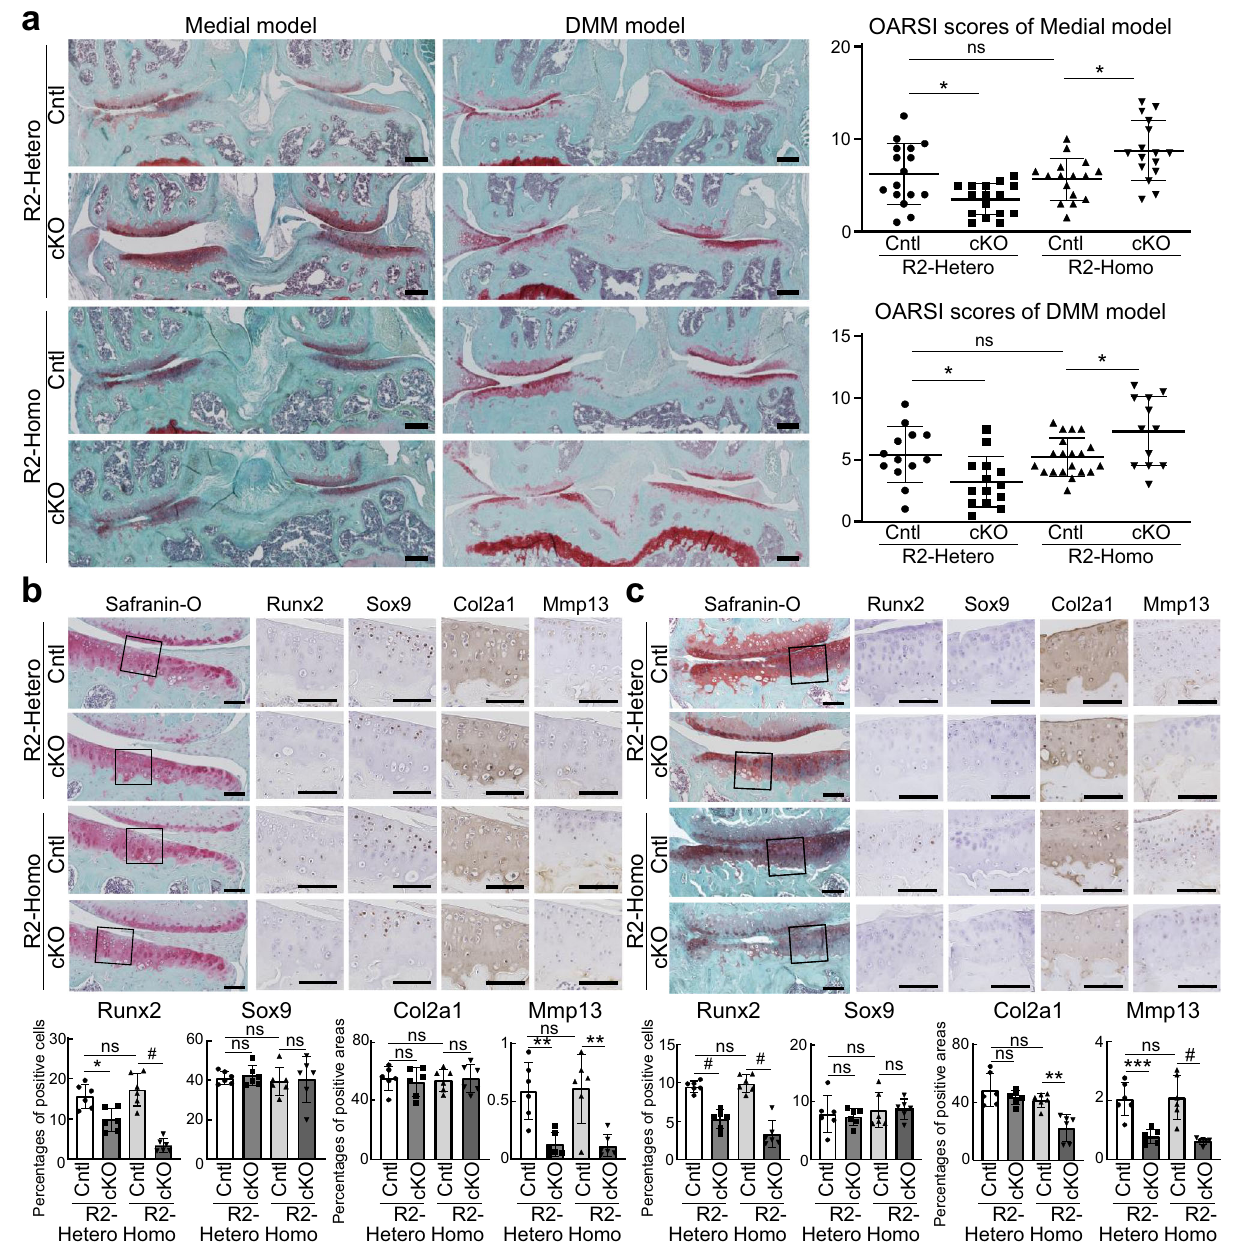
Fig. 3 | Osteoarthritis development in chondrocyte-speci fi c homozygous and heterozygous Runx2-knockout mice. a Safranin-O staining and Osteoarthritis ResearchSocietyInternational(OARSI)scoresofmousekneejointsof Runx2 fl /+ (R2- Hetero Cntl), Col2a1-Cre ERT2 ; Runx2 fl /+ (R2-Hetero cKO), Runx2 fl / fl (R2-Homo Cntl), and Col2a1-Cre ERT2 ; Runx2 fl / fl (R2-Homo cKO) mice 12 weeks after surgery to desta- bilize the medial meniscus (DMM) or 8 weeks after resection of the medial meniscus and medialcollateralligament (medial model).Tamoxifeninductionwas performed at 15 weeks in the DMM group and 7 weeks in the medial model group.